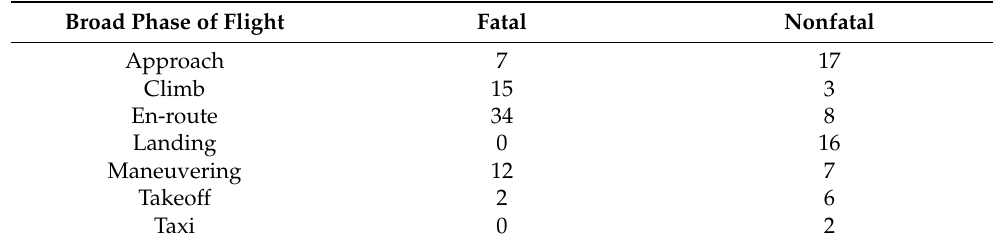
Table 2. Number of fatal and nonfatal accidents that occurred during each broad phase of flight. Broad Phase of Flight Fatal Nonfatal